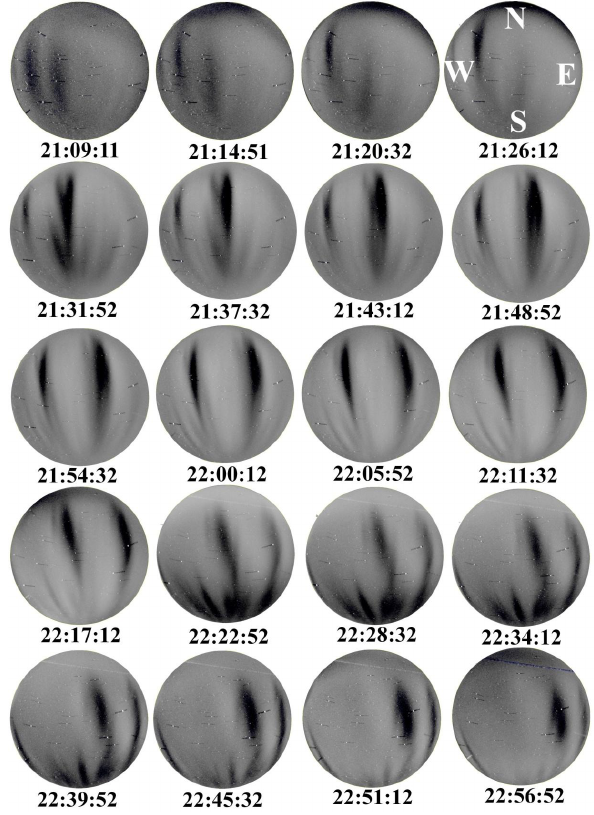
Fig. 2. A few sequences of OI 630.0nm images taken on 1– Fig. 2. Few sequence of OI 630.0 nm images taken on 01-02 April 2011 from 21:09:11 IST 2 April 2011 by ASI from to 22:56:11 IST by ASI from Kolhapur.